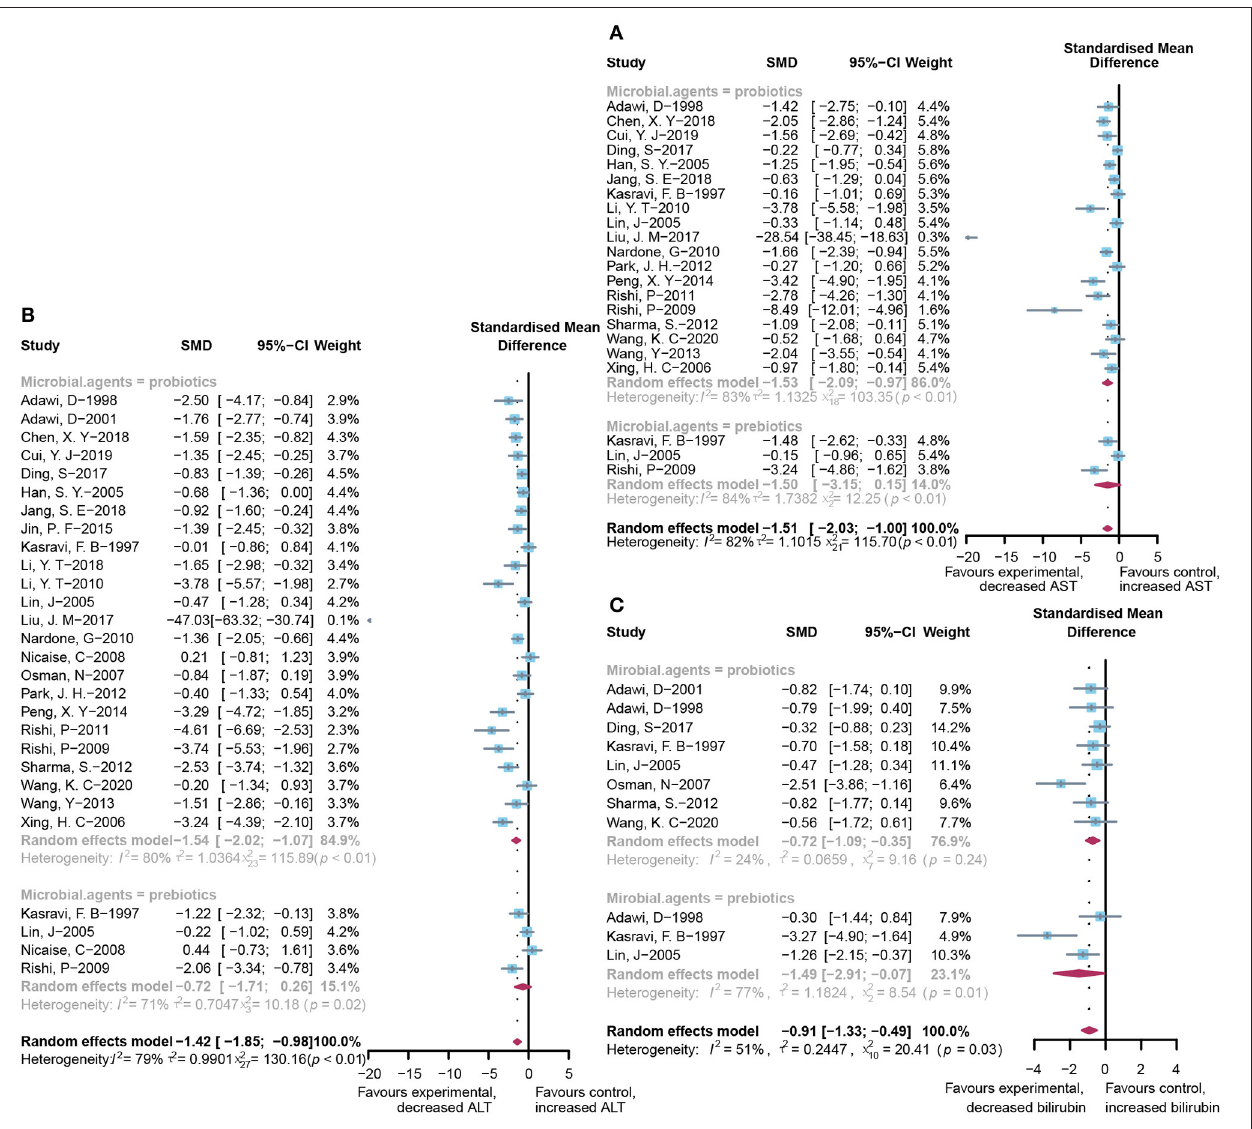
FIGURE 2 | Effectiveness of microbial agents on liver biochemical index. (A) The effect of microbial agents on AST, (B) ALT, and (C) bilirubin.